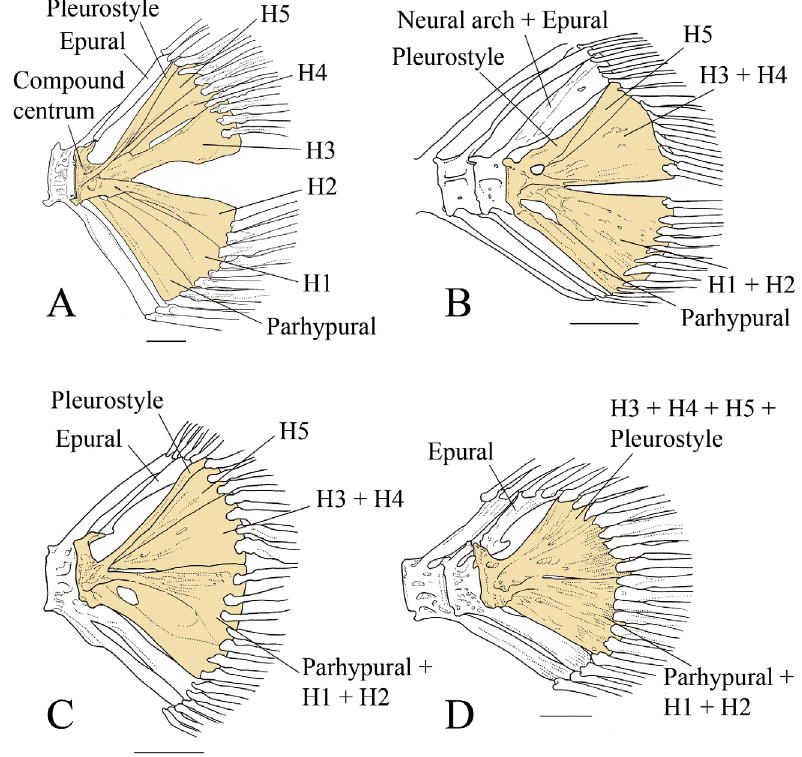
FIGURE 9 | Lateral view of caudal bones; anterior to left: A. Steindachneridion scriptum , MZUEL 19302; B. Rhamdia quelen , MZUEL 11664; C. Pseudopimelodus mangurus , MZUEL 17286; D. Lophiosilurus alexandri , MZUEL 13288. Scale bars = 5